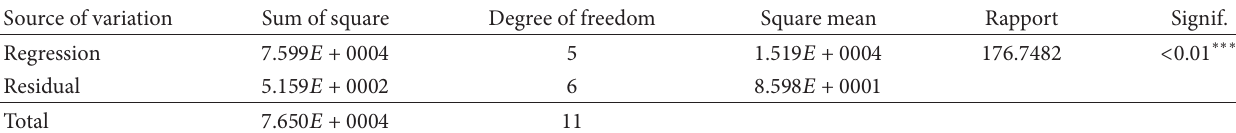
T 5: Analysis of variance of iodine adsorption, I